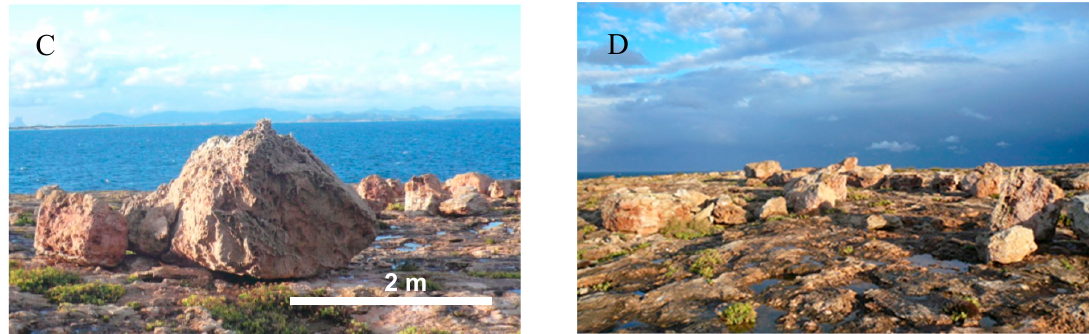
Figure 10. ( A ) Geomorphological scheme of the Punta Prima area. Roses show the dominant orientation of boulders and the prevailing waves. ( B ) Cli ff on which the analyzed boulders are located. ( C ) Large block located at 11.5 m a.s.l., and dated in the year 1792 BC. ( D ) Block ridge located 115 m from the cli ff edge, and 12.9 m a.s.l.